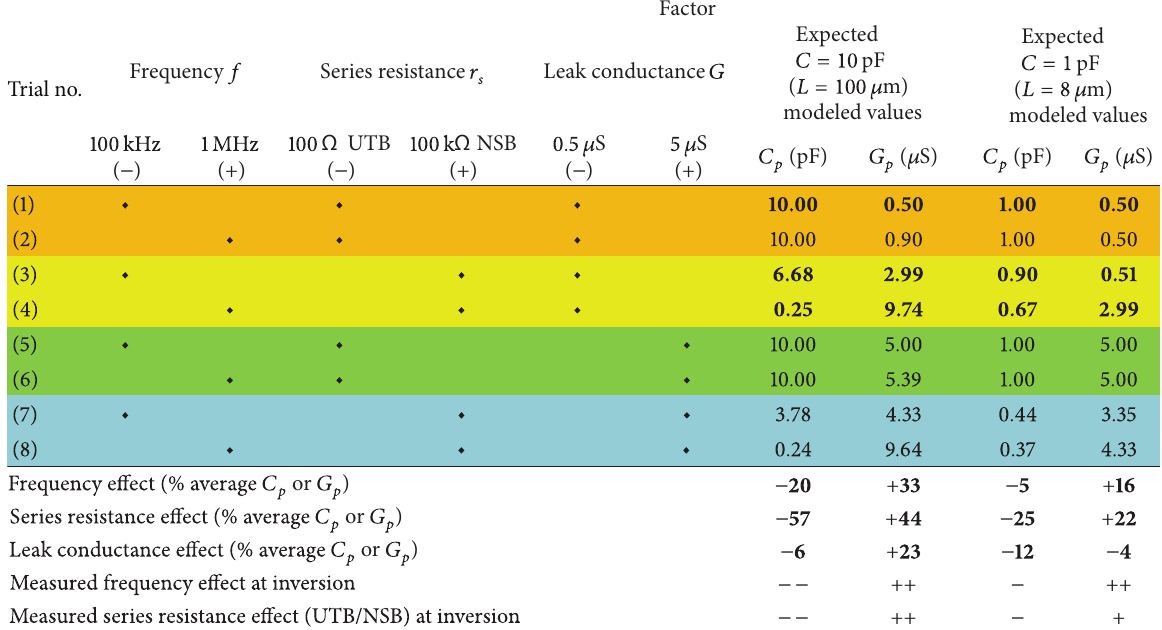
Table 1: Two-level factorial plan of the modeled values 𝐶 𝑝 and 𝐺 𝑝 for three factors: (1) frequency, (2) series resistance (according to NSB or UTB device), and (3) leak conductance. The channel length influence (100 𝜇 m versus 8 𝜇 m) is linked to the expected (actual) 𝐶 value. The low and high factor levels are indicated by ( − ) and (+) sign.